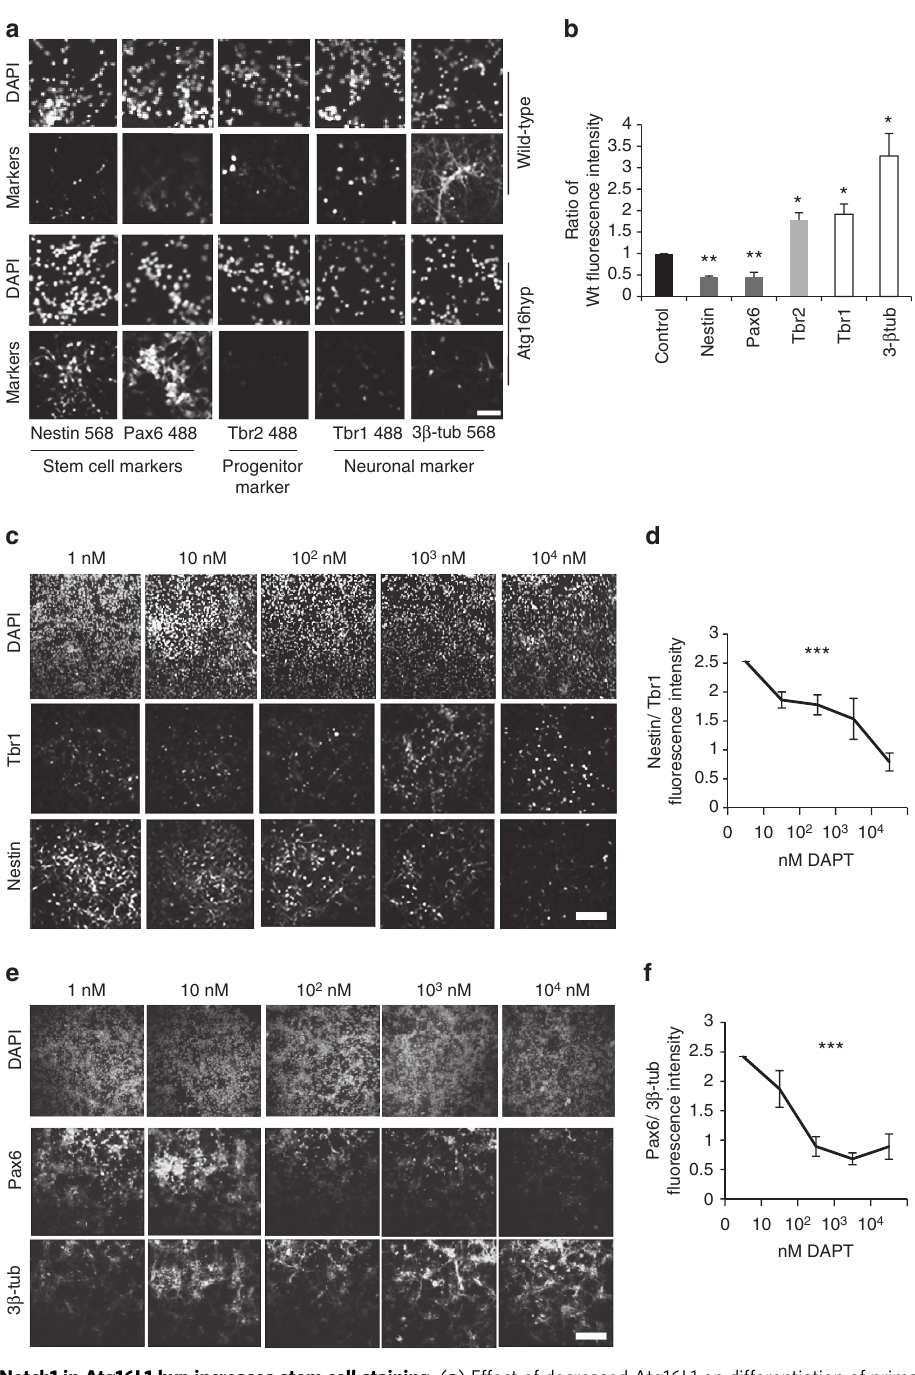
Figure 7 | Increased Notch1 in Atg16L1 hyp increases stem cell staining. ( a ) Effect of decreased Atg16L1 on differentiation of primary neurons in culture. Wild-type and Atg16L1 hyp primary cortical neurons were stained for stem cell markers (Nestin, Pax6), progenitor marker Tbr2 and neuronal markers (Tbr1, b 3-tub). Scale bar ¼ 100 m m is valid for all panels. ( b ) Quantification of relative fluorescence intensity of immunostaining for markers of stem cells (dark grey bars), progenitors (light grey bars) neurons (white bars) as shown in a. Intensity is expressed as a ratio of wild-type (Wt) to Atg16L1 hypomorph (Atg16hyp) * P o 0.05 by paired t -test. n ¼ 3. Error bars ¼ s.e.m. ( c ) Effect of Notch pathway inhibition (by DAPT) on the differentiation of Atg16L1 hypomorph primary neurons. Neurons from E15.5 Atg16L1 hypomorph (Atg16hyp) mice were treated with increasing concentration of DAPTand stained for Nestin and Tbr1. Scale bar, 200 m m is valid for all panels. ( d ) Quantification of fluorescence intensity of immunostaining for stem cell marker Nestin and neuronal marker Tbr1 in neuronal cultures from Atg16L1 hypomorph mice following DAPT treatment at different concentrations as shown in c. The values are shown as a ratio of stem cell marker relative to neuronal marker to correct for any differences in cell number. *** P o 0.001 by analysis of variance. n ¼ 3. Error bars ¼ s.e.m. ( e ) Effect of Notch pathway inhibition (by DAPT) on the differentiation of Atg16L1 hypomorph primary neurons. Neurons from E15.5 Atg16L1 hypomorph (Atg16hyp) mice were treated with increasing concentration of DAPTand stained Pax6 and 3 b -tub. Scale bar, 200 m m is valid for all panels. ( f ) Quantification of stem cell marker Pax6 relative to neuronal marker 3 b -tub as described in e. n ¼ 3. Error bars ¼ s.e.m.